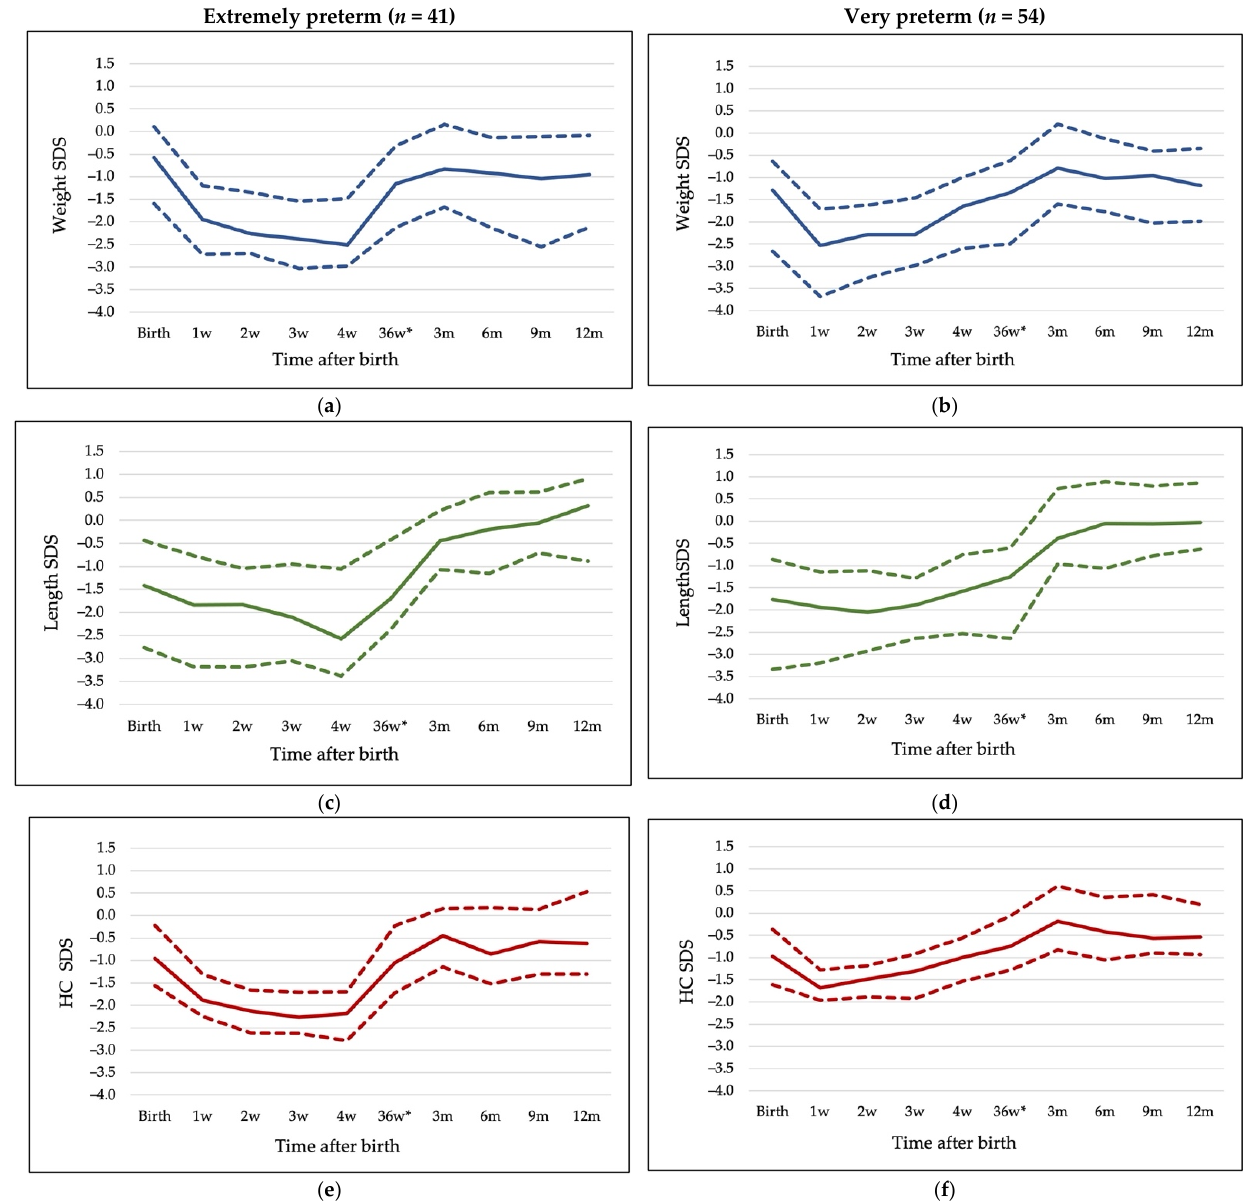
Figure 2. Growth patterns of groups during the first year of life. ( a ) Weight SDS in EP group, ( b ) Weight SDS in VP group, ( c ) Length SDS in EP group, ( d ) Length SDS in VP group, ( e ) Head circumference SDS in EP group, ( f ) Head circumference SDS in VP group. Values are median (solid line) and interquartile range (IQR) (dashed lines). 36w*—36 weeks of CGA or